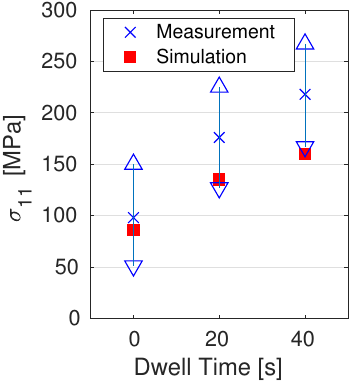
Figure 11. Residual